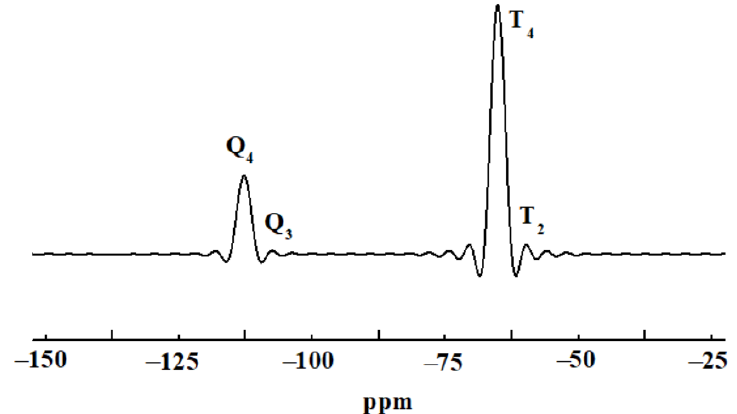
are shown in Figure 9. According to previous reports [39,40], the peaks at − 58 ppm and